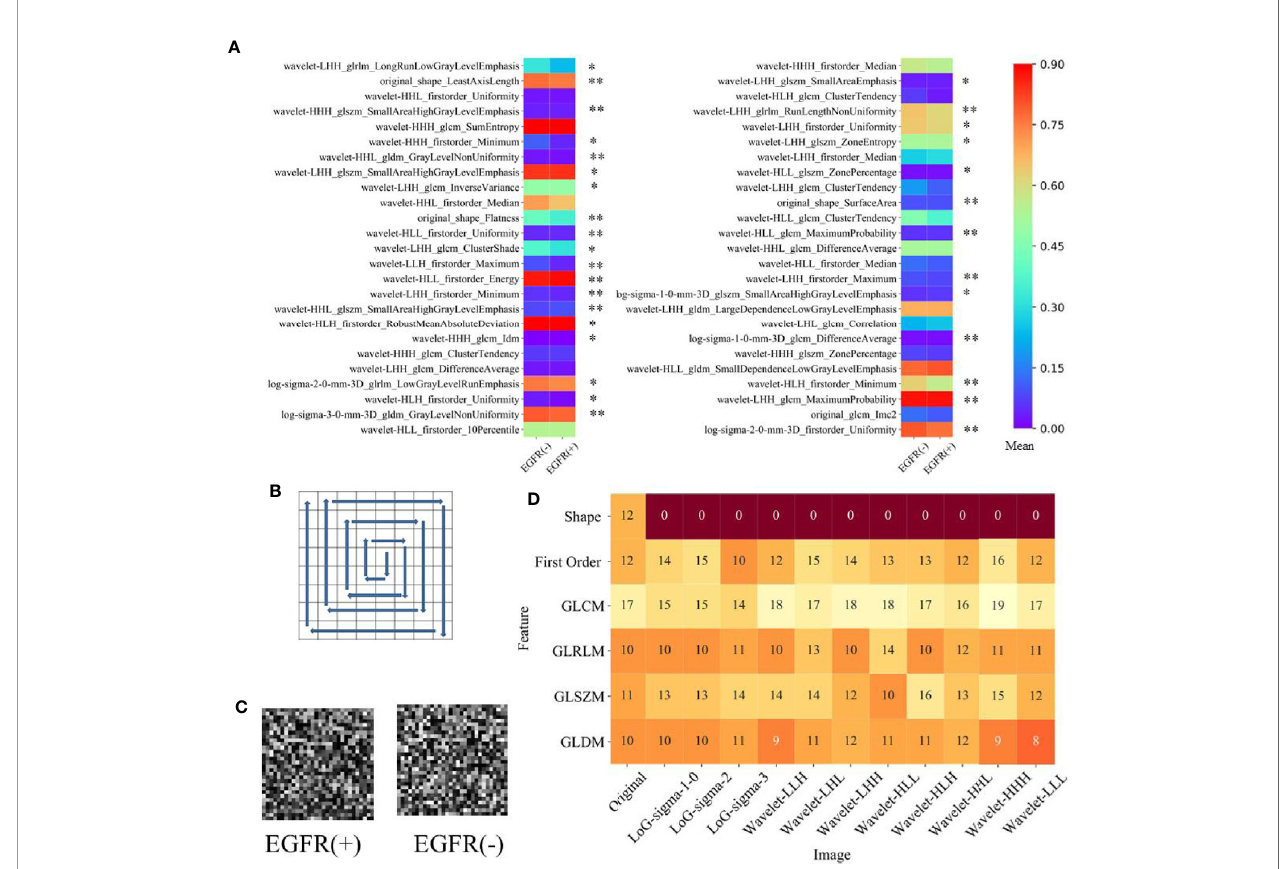
FIGURE 3 | The selected radiomics features. (A) The mean value of 50 highly informative features in EGFR(+) and EGFR(-). *represents p <0.05 between EGFR(+) and EGFR(-), **represents p <0.001 between EGFR(+) and EGFR(-). (B) Clockwise sorting method for input matrix of deep learning model. (C) The example of the input matrix. (D) Distribution of selected 784 features used in deep learning